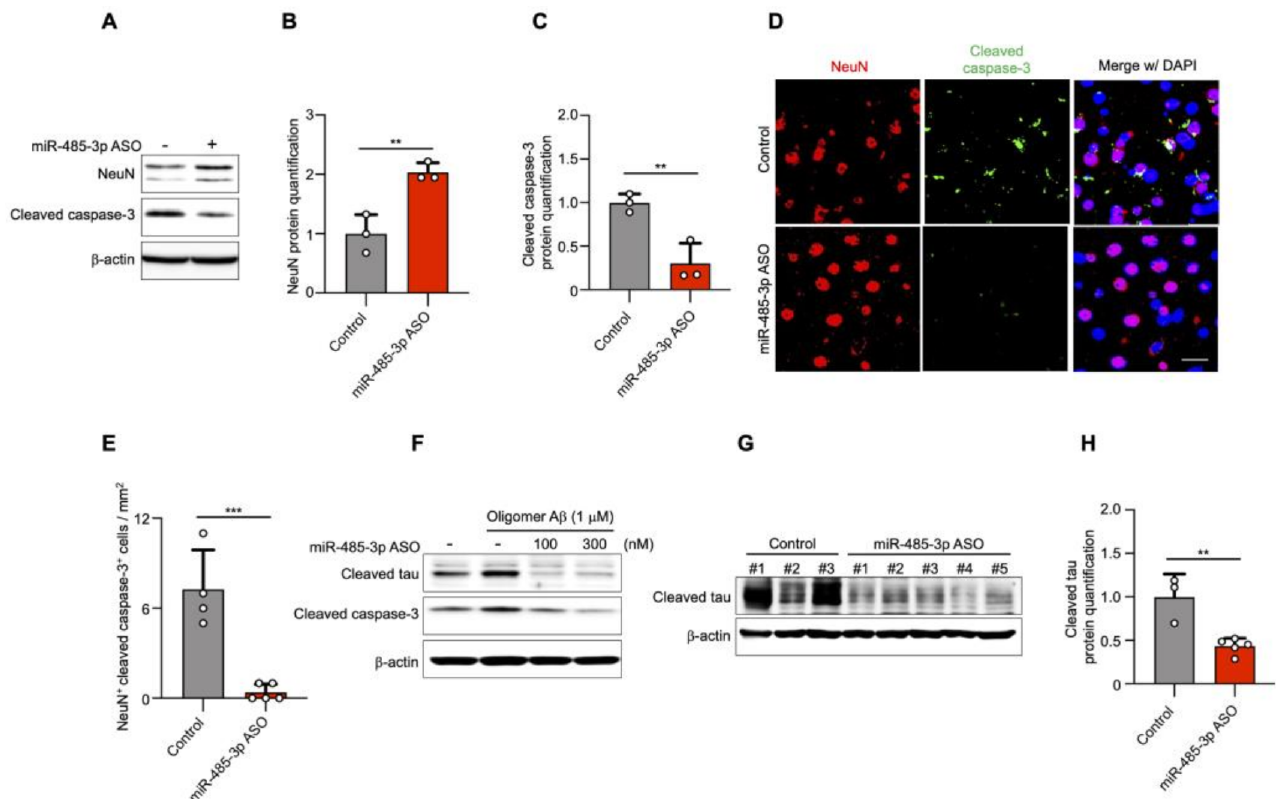
Figure 4. miR-485-3p antisense oligonucleotide (ASO) reduces apoptosis and truncated tau level. ( A ) Immunoblotting for NeuN and cleaved caspase-3 expression in fractions from the cortex region of control- or miR-485-3p ASO-injected 10- month-old 5XFAD mice. Data are representative of three independent experiments. ( B , C ) Relative protein quantification of NeuN ( B ) and cleaved caspase-3 ( C ) obtained from ( A ). Data obtained across four independent experiments are expressed as mean ± SD. ( D ) Immunohistochemical staining for NeuN and cleaved caspase-3 in coronal brain sections from control- or miR-485-3p ASO-injected 10-month-old 5XFAD mice. Scale bars, 20 µ m. Data are representative of three independent experiments. ( E ) Quantification of the NeuN + cleaved caspase-3 + cells from control- ( n = 4) or miR-485-3p ASO- ( n = 5) injected 10-month-old 5XFAD mice. ( F ) Primary cortical neurons were treated with 1 µ M oligomeric A β (1–42) for 6 h; lysates were immunoblotted with cleaved tau or cleaved caspase-3 antibodies. Data are representative of three independent experiments. ( G ) Immunoblotting for cleaved tau protein expression in control- ( n = 3) or miR- 485-3p ASO- ( n = 5) injected 10-month-old 5XFAD mice. ( H ) Relative protein quantification of cleaved tau obtained from ( G ). Data obtained over three independent experiments are expressed as mean ± SD. ** p < 0.01; *** p < 0.001 (two-tailed t